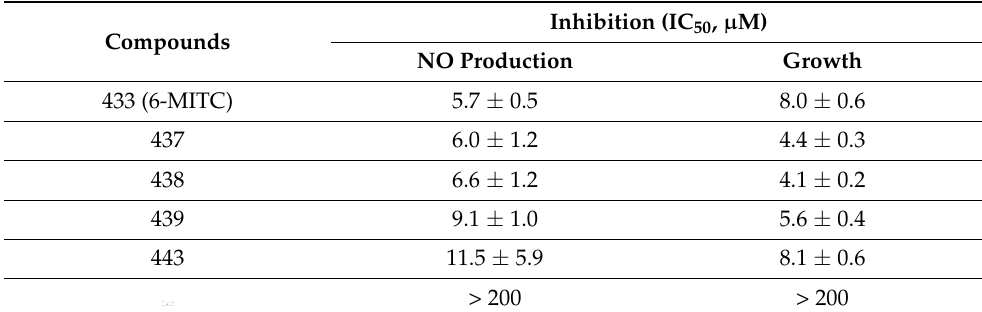
Figure 49. Synthesis of 1-isothiocyanato-6-methoxyhexane ( 443 ) and 1-isothiocyanato-6- (methylthio)hexane ( 444 ). Table 11. In vitro NO production and tumor growth inhibitory activities of the most active ITCs 433 , 437 – 439 , 443 , and thiocyanate 445